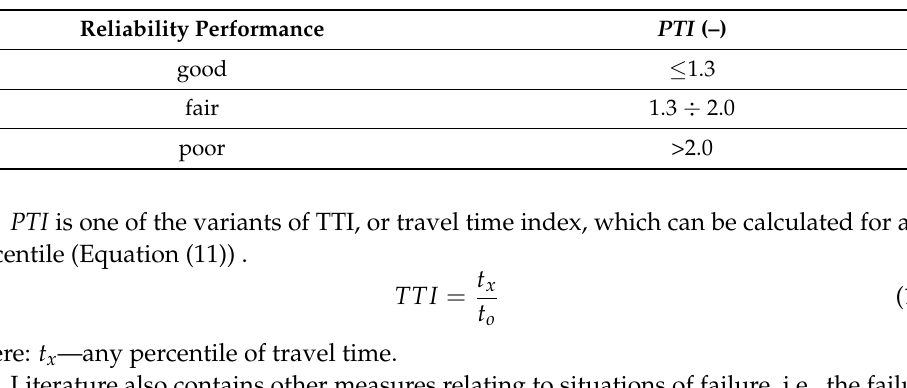
Table 2. Thresholds values of PTI for individual levels of functional reliability.